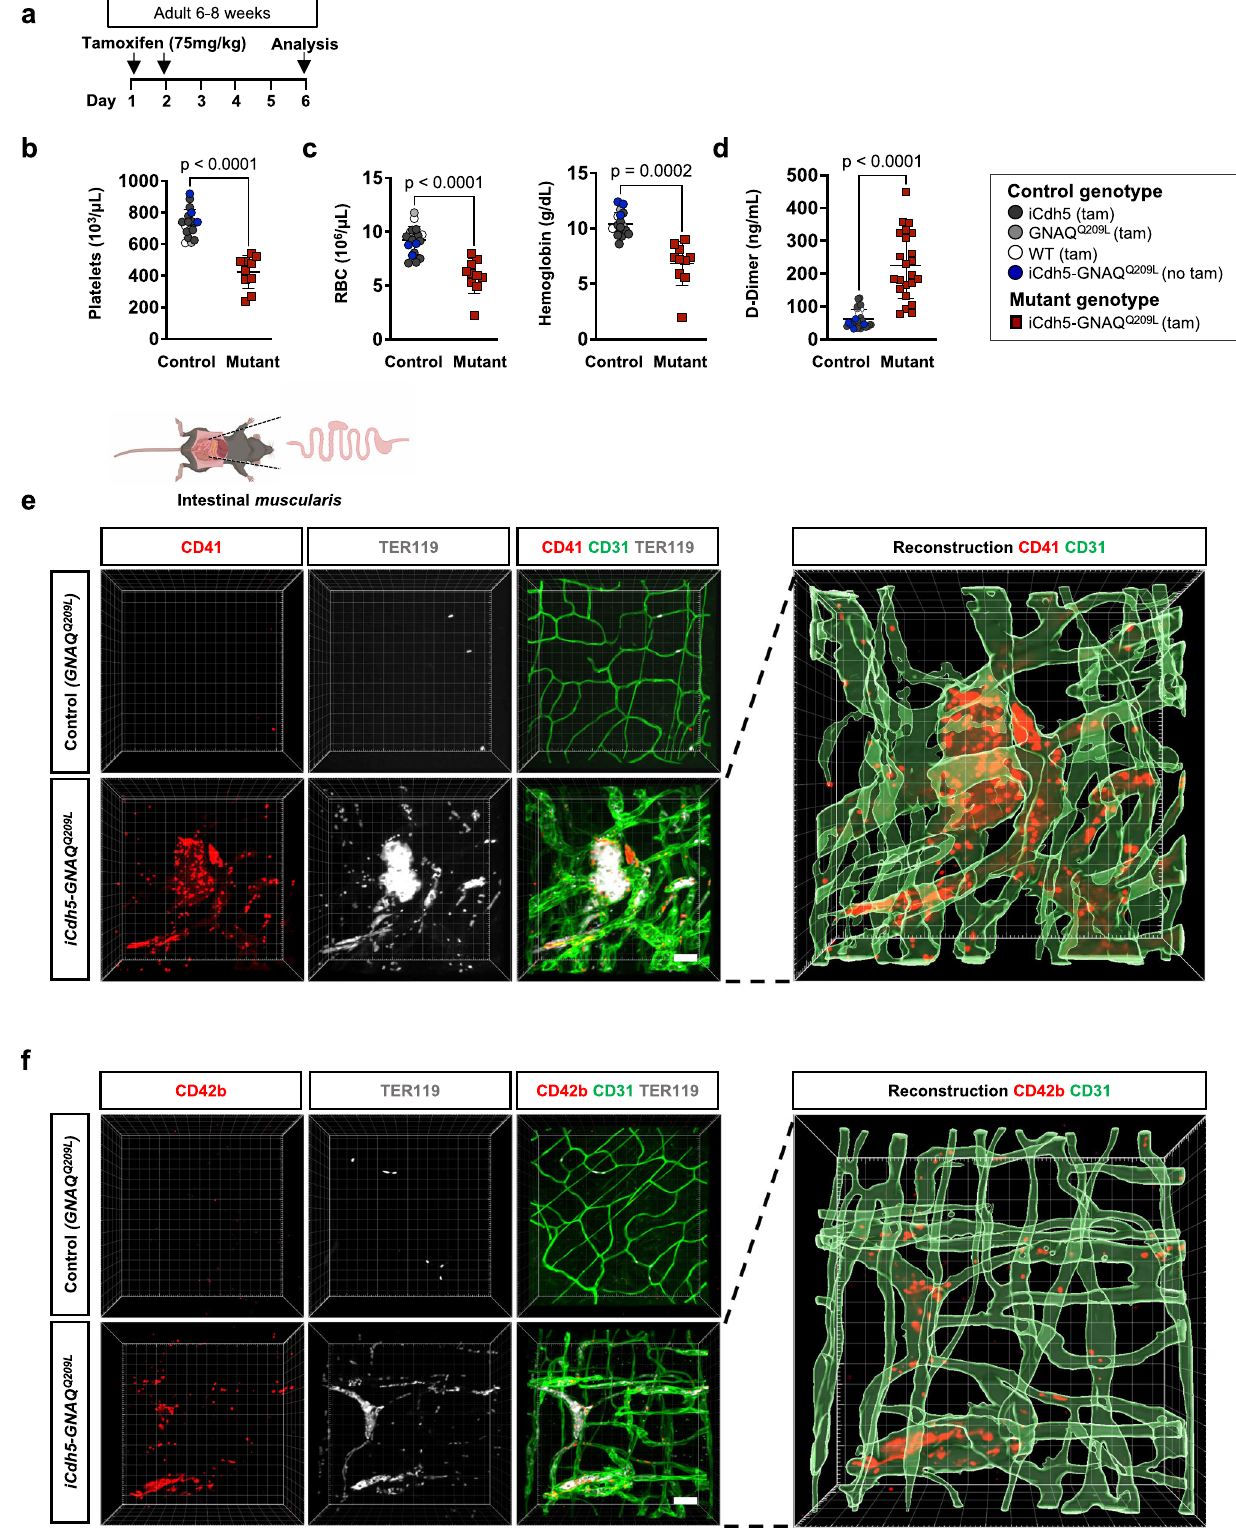
Fig. 4 | Mice expressing GNAQ Q209L in the vasculature develop thrombocyto- penia and severe coagulopathy. a Tamoxifen induction scheme. b-c Hematolo- gical parameters were measured in iCdh5-GNAQ Q209L ( n =10) and controls ( n =18), mean±SD, unpaired two-tailed Welch ’ s t-test. Mouse genotypes are indicated. b Plateletcounts, c RBC (red blood cellcounts),and hemoglobin levels. d D-Dimer levelsweremeasuredinplasmasamplesfrom iCdh5-GNAQ Q209L ( n =23)andcontrols